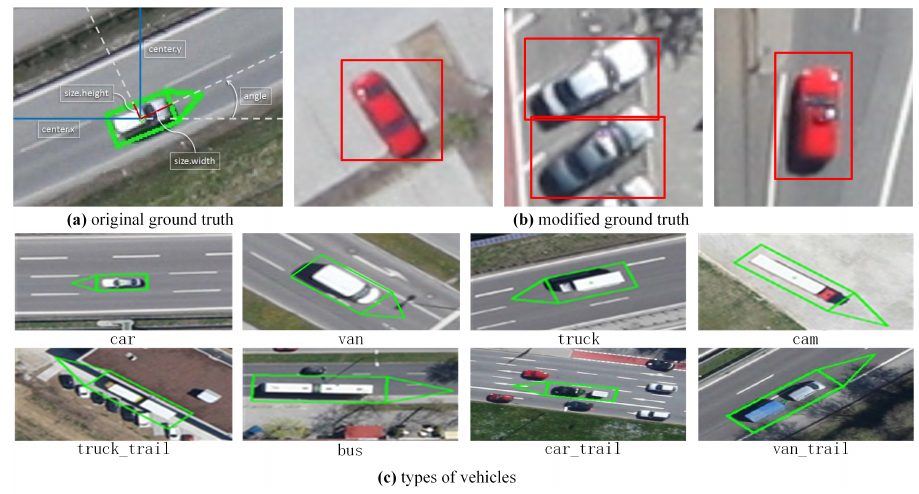
Figure 5. Ground truth of the original Munich dataset, our modified ground truth and types of